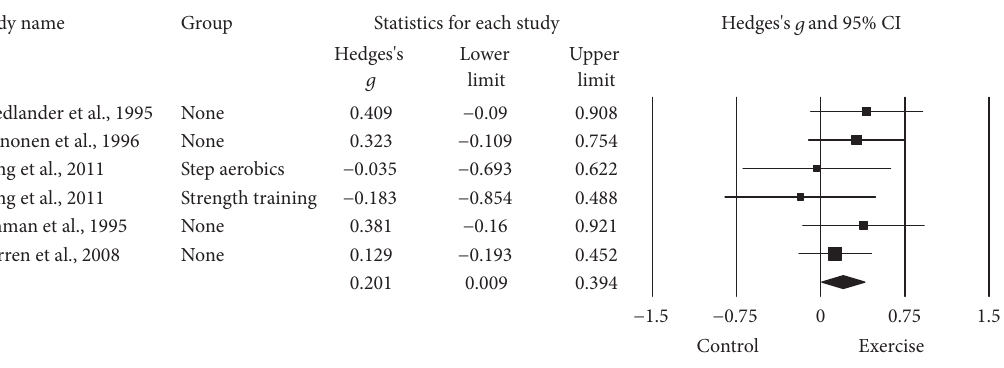
) in LS BMD. e black squares con�dence ) while the le and right extremes of the 𝑔𝑔 % 𝑔𝑔